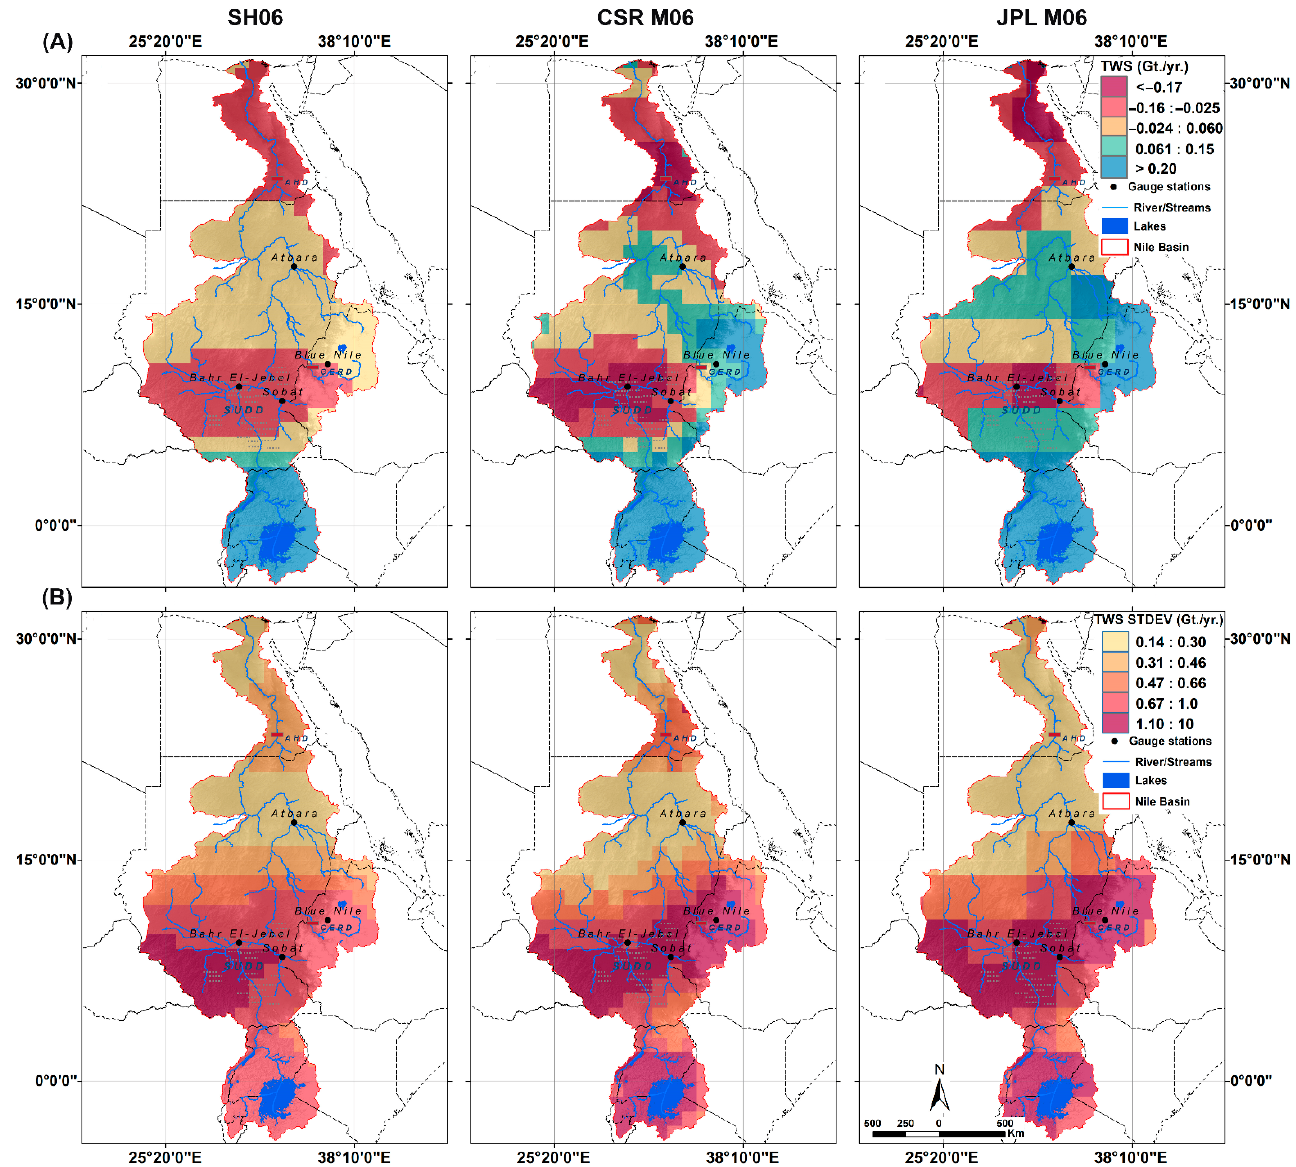
Figure 7. Mean annual average GRACE TWS ( A ) between 2002–2017 using ensembled SH06, CSR-M06, and JPL-M06 mascon solutions, plot ( B ) shows the standard deviation of each solution.